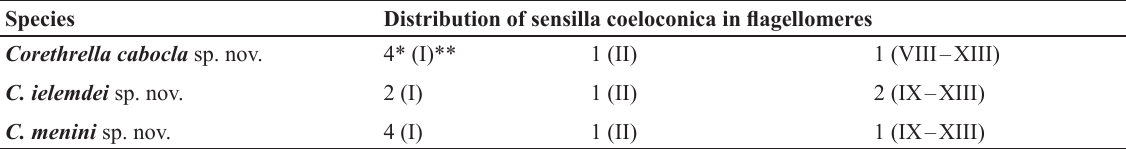
Table 2. Wing length measurements of the new female species of Corethrella Coquillet, 1902 in mm. Species Number Wing length Mean 1.5SD R